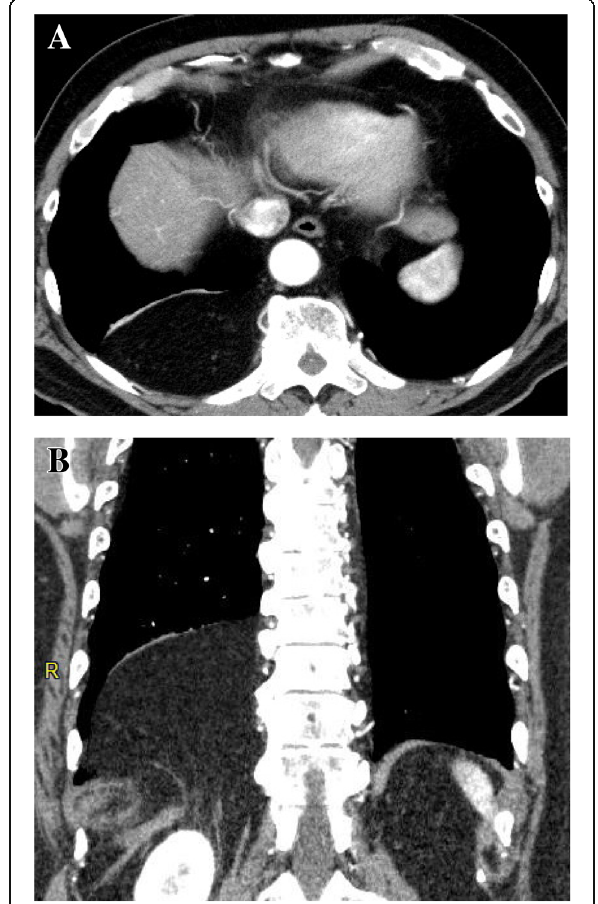
Fig. 2 Chest CT images showing a a well-circumscribed mass in the right dorsal thoracic space measuring 28 × 9× 10 cm and compressing the right lower lobe. b The tumor is mostly composed of fatty density and seemed to connect with retroperitoneal